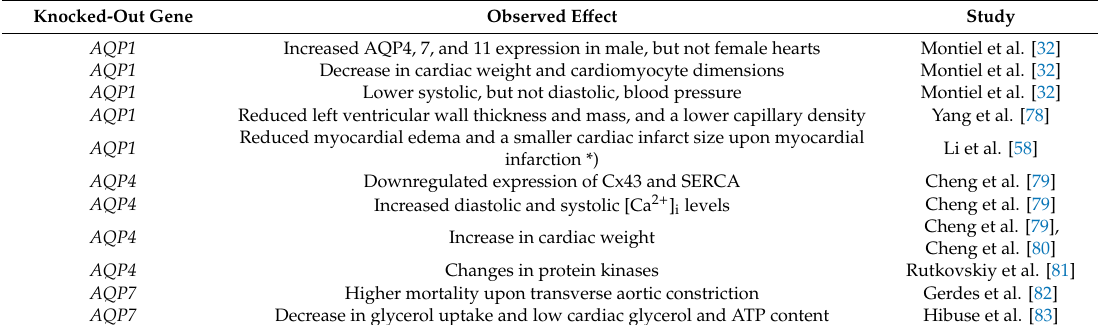
Table 3. Observations in the heart from studies on AQP knock-out